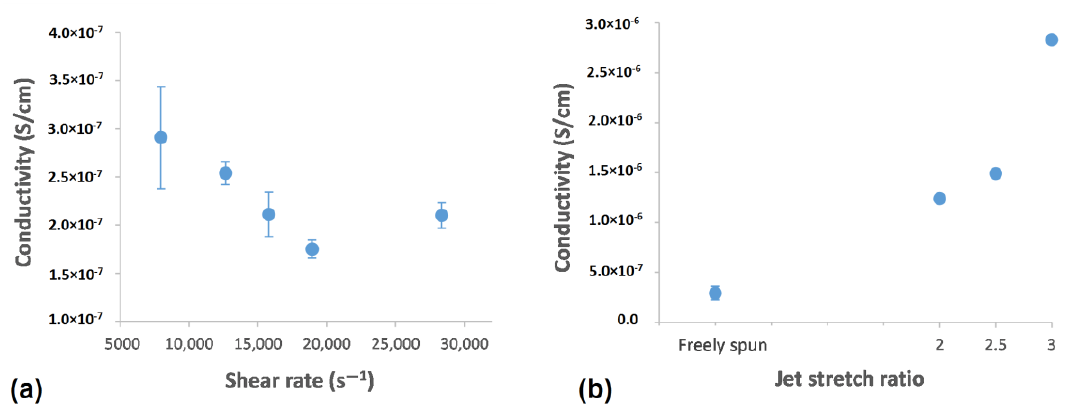
Figure 12. Electrical conductivity of PAN/CNT fibers as a function of ( a ) shear rate and ( b ) jet stretch stretch ratio.